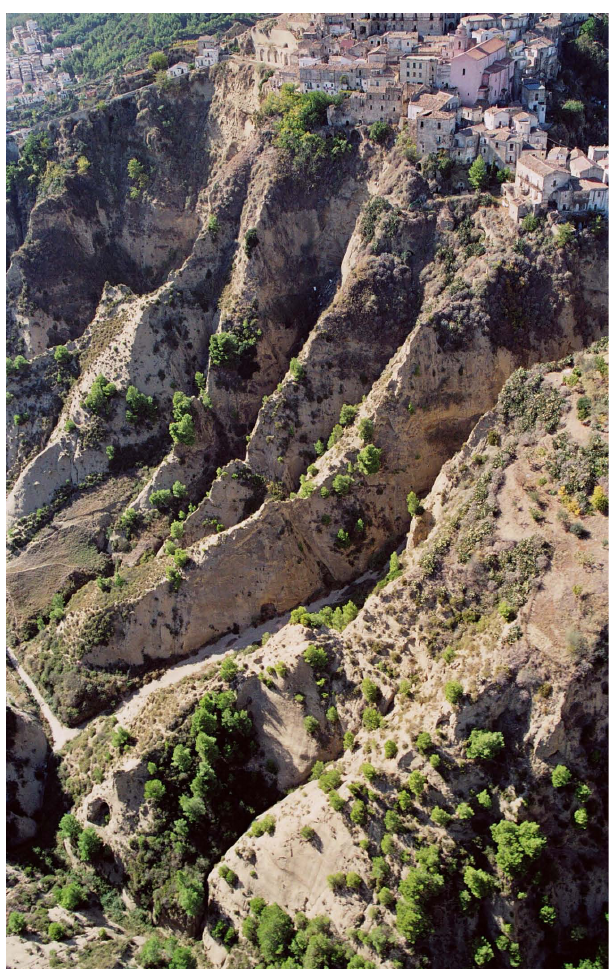
Fig. 3. Aerial view of Rabatana showing the deep gullies distributed around all the urban perimeter and due to intence erosional pro- cesses.